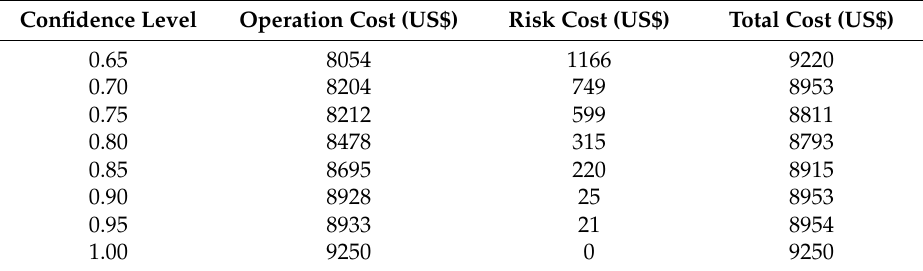
Table 7. Fuzzy optimal scheduling results under different confidence